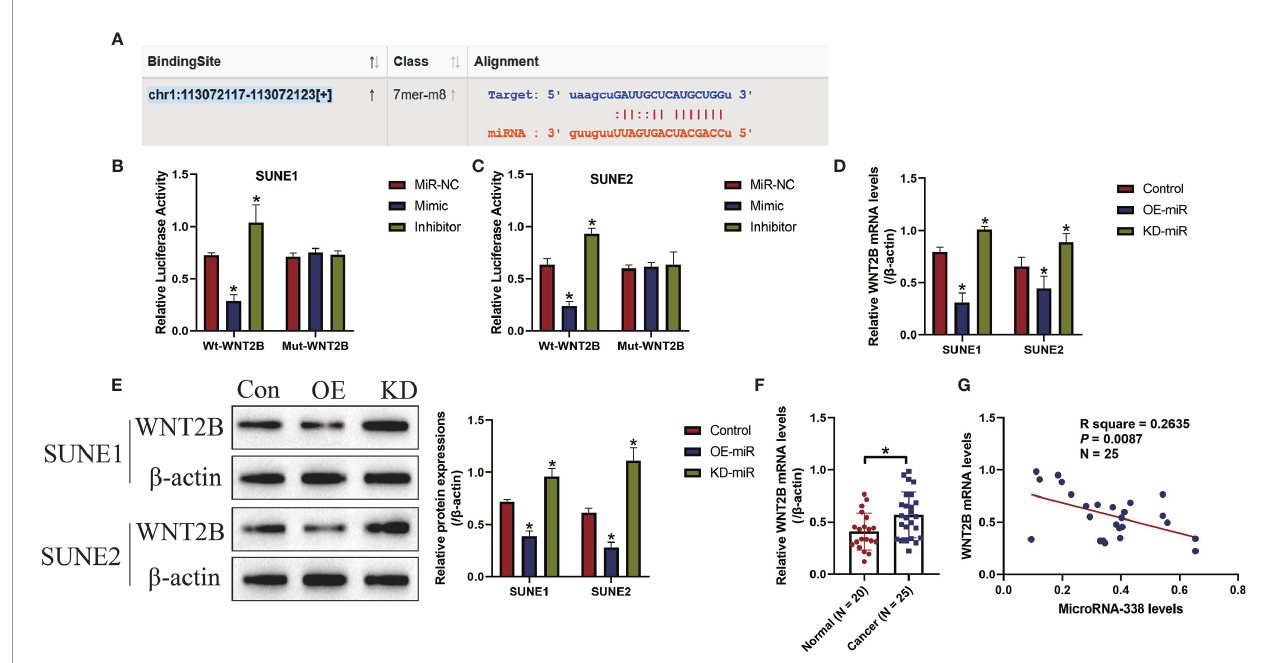
FIGURE 4 | MicroRNA-338-5p targeted 3 ’ untranslated region (3 ’ UTR) of WNT2B mRNA for its degradation and inhibition. (A) The binding sites in microRNA-338- 5p and 3 ’ UTR of WNT2B mRNA were predicted by using the online starBase software (http://starbase.sysu.edu.cn/). (B, C) The above targeting sites were validated by the dual-luciferase reporter gene system assay in NPC cells. MicroRNA-338-5p negatively regulated the expression levels of WNT2B at both (D) transcriptional and (E) translated levels, determined by Real-Time qPCR and Western Blot analysis, respectively. (F) WNT2B mRNA was upregulated in NPC tissues, compared to the normal tissues. (G) Pearson correlation analysis was performed to analyze the correlations between microRNA-338-5p and WNT2B mRNA in NPC tissues. Each experiment repeated at least three times, and * P <